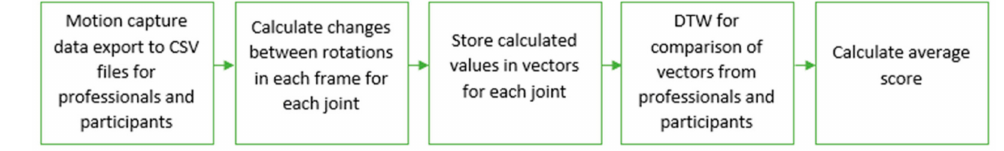
Figure 2. Workflow for data